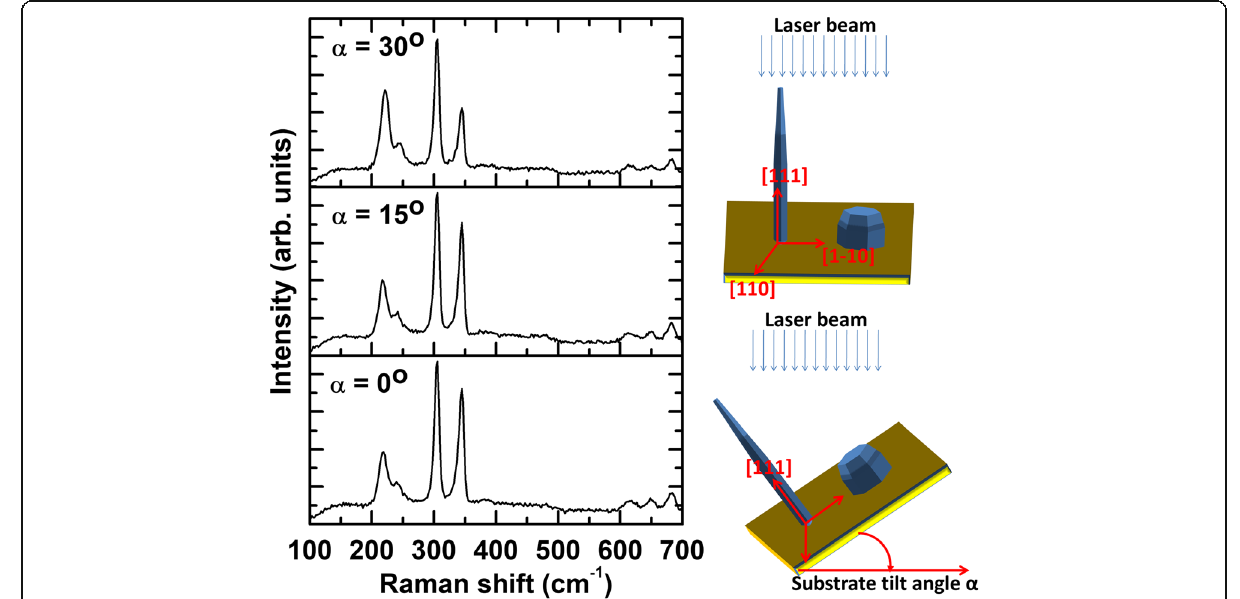
Fig. 3 Effect of substrate tilting on Raman active modes in InP/InAs/InP